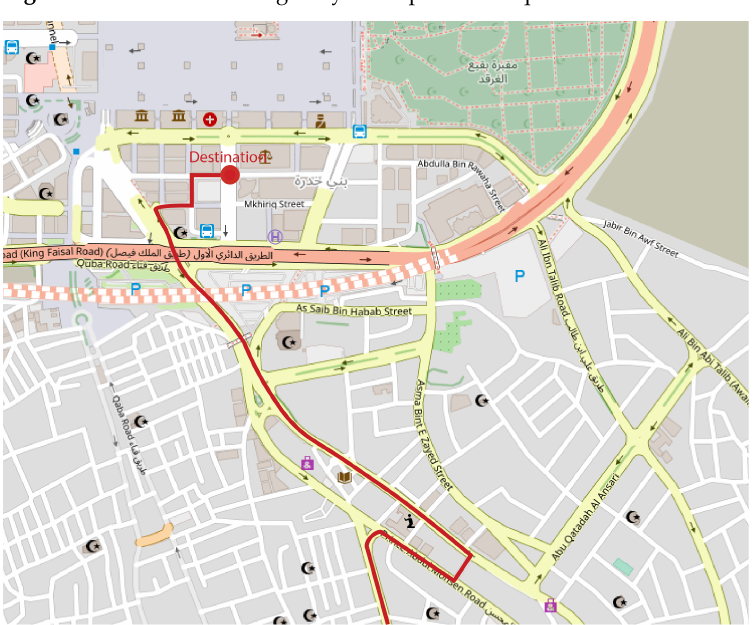
Figure 7. Route 2—South Highway to Prophet’s